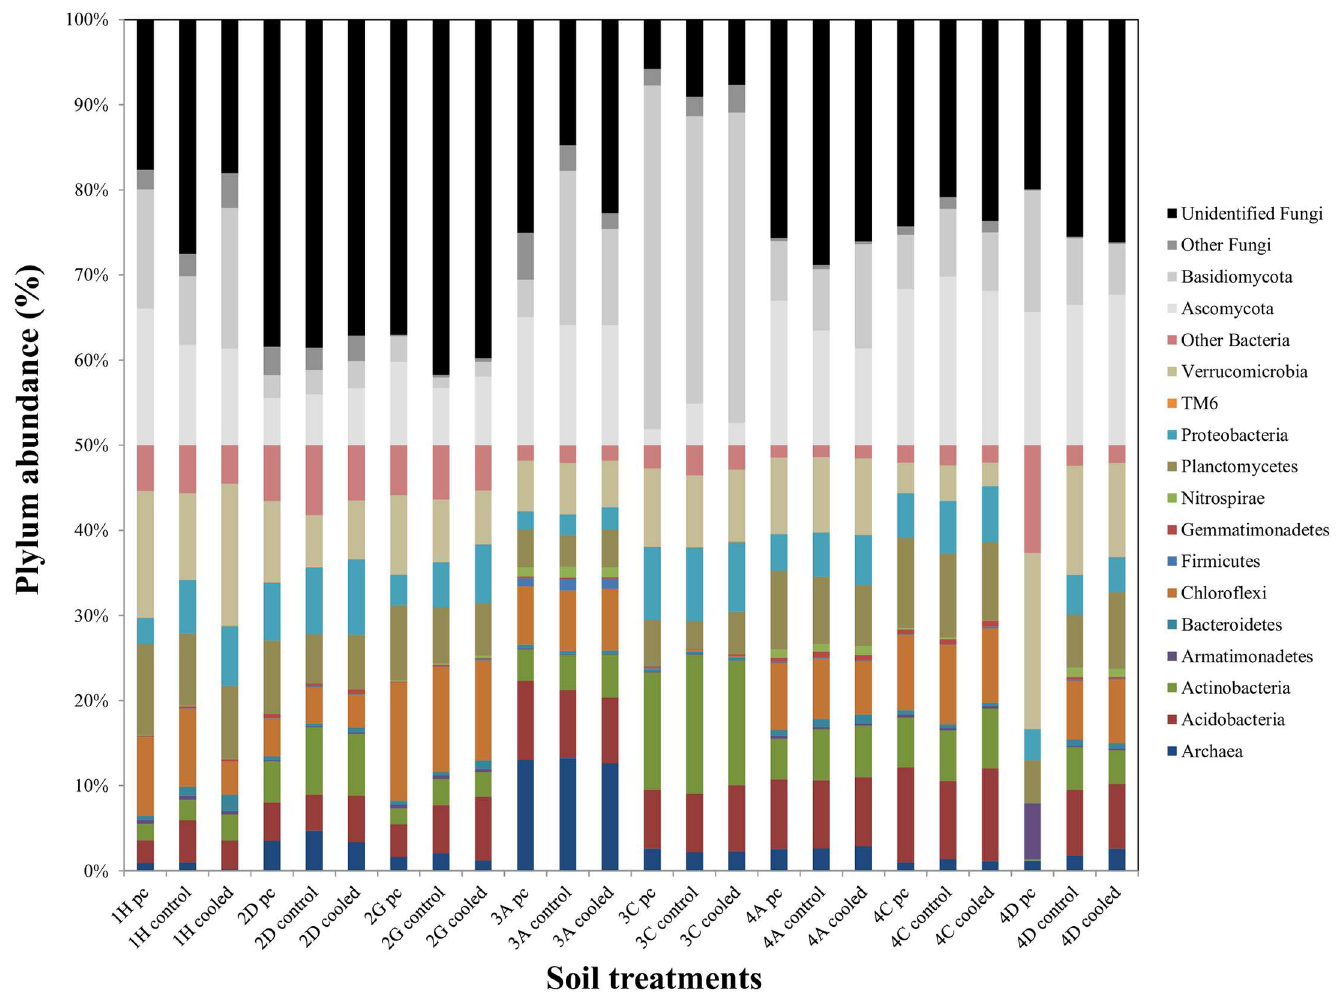
Fig 2. Community composition based on pyrosequencing. The relative abundanceof each microbial phylum (Archaea, n = 1; Bacteria, n = 13; Fungi, n = 4) is indicatedfor precooling(pc), control and cooledtreatments.